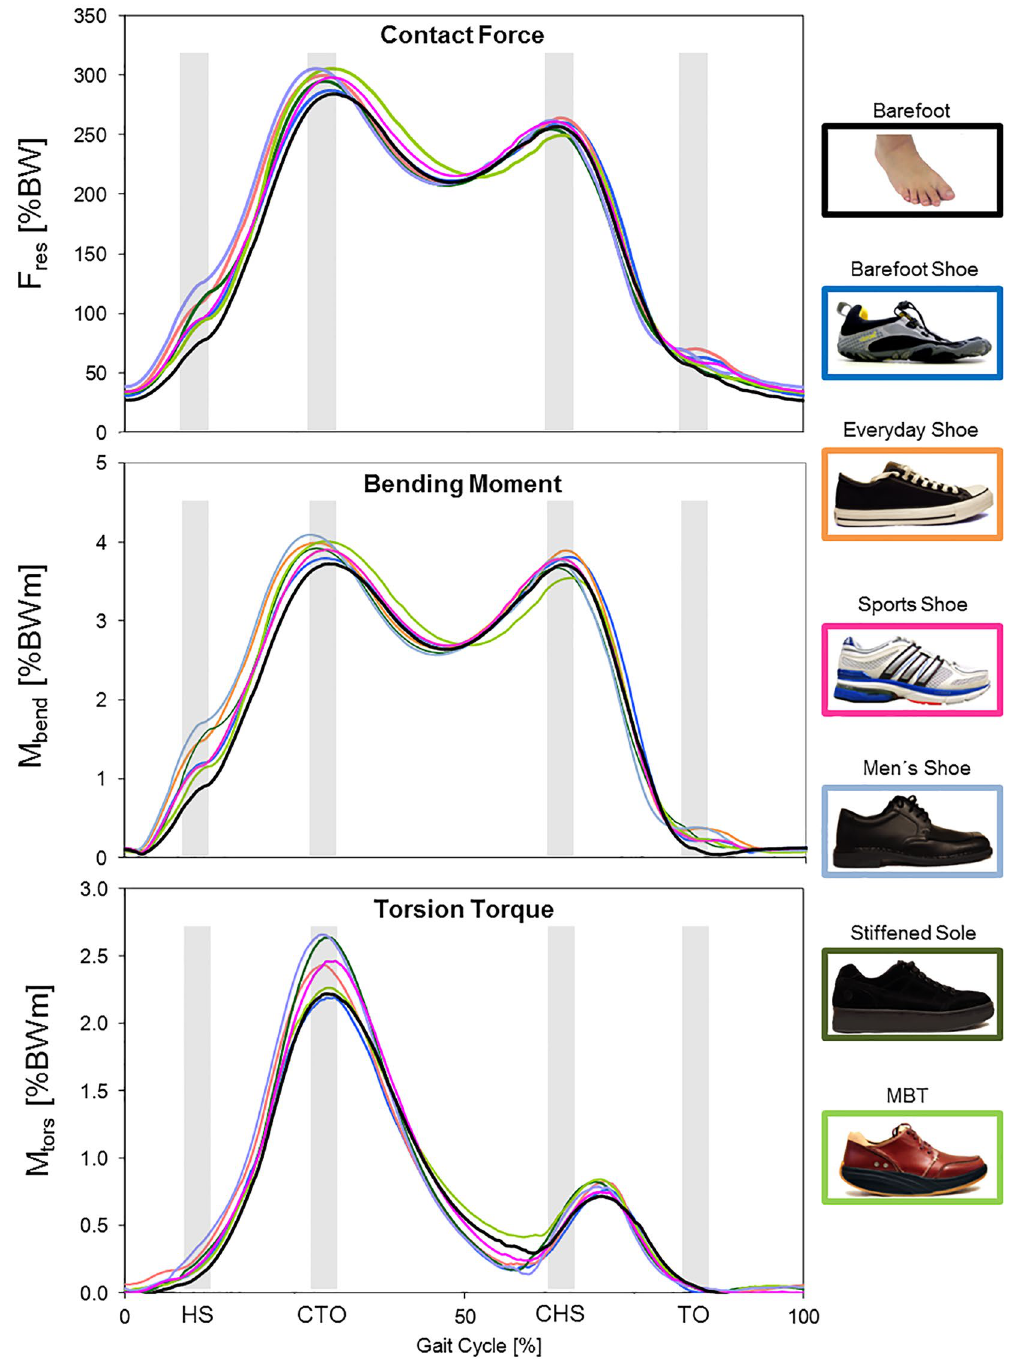
Figure 2. In vivo acting hip joint loads—resultant contact force (F res ), bending moment (M bend ) and torsional moment (M tors )—during walking with different shoes. BW body weight, BWm body weight